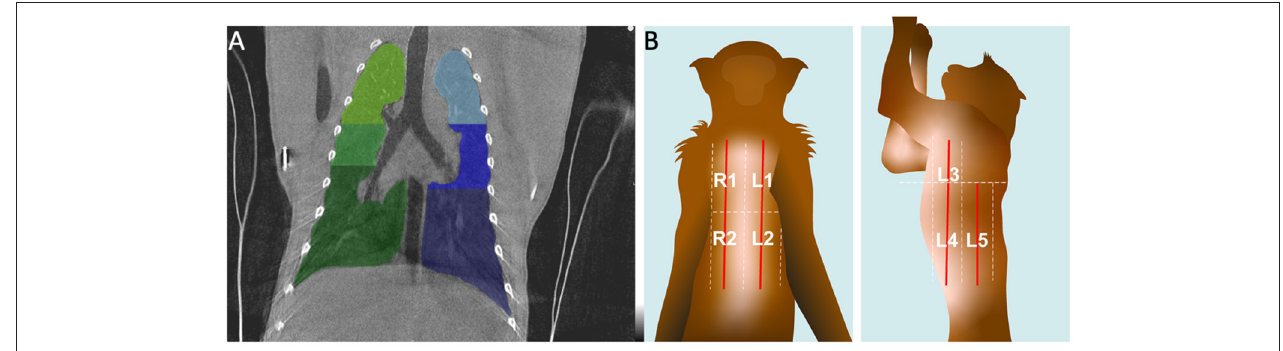
FIGURE 2 | (A) Represents the semi-quantitative score of each study day, the dots represent each individual macaque. D0 is obtained pre-infection. Per day the average and standard error of mean are visualized. (B) The distribution of the lesions scored for each modality over all study days.